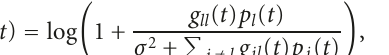
Figure 1: Self-interference for a link pair ( i , j ) ∈ A .